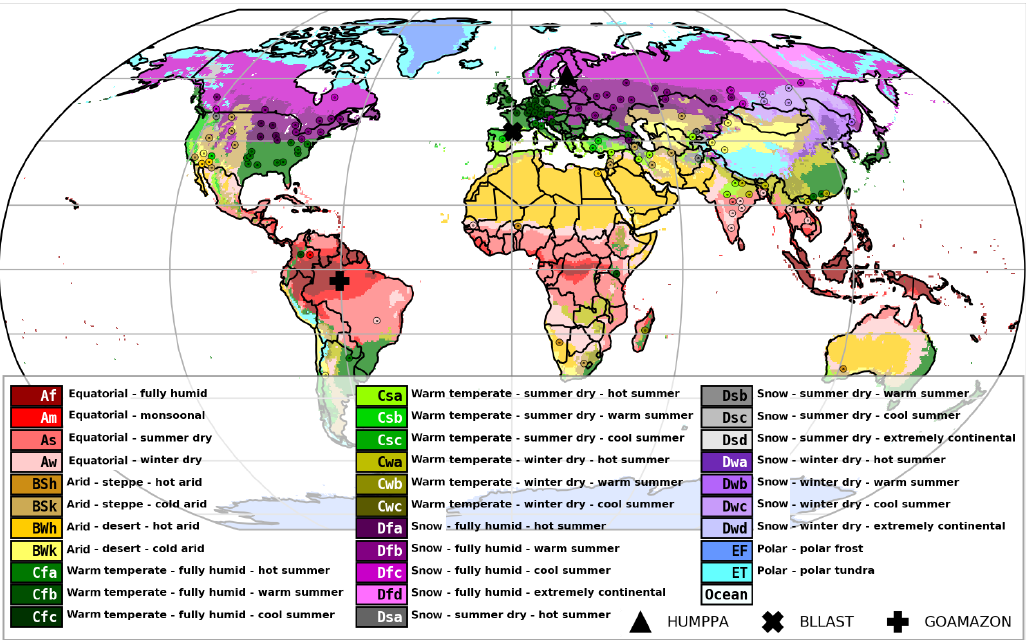
Figure 2. Distribution of the launch sites from the Integrated Global Radiosonde Archive (IGRA) retained after the profile quality selection procedure. The different climate classes are indicated with the colors according to the Köppen–Geiger climate classification. The markers indicate the locations of the three observation campaigns (i.e., HUMPPA, BLLAST and GOAMAZON). The profile quality selection is described and presented in Sect.